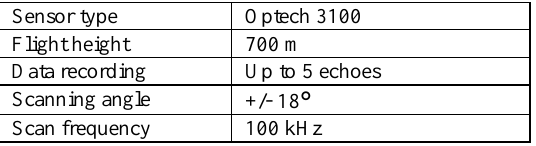
Table 1. ALS data